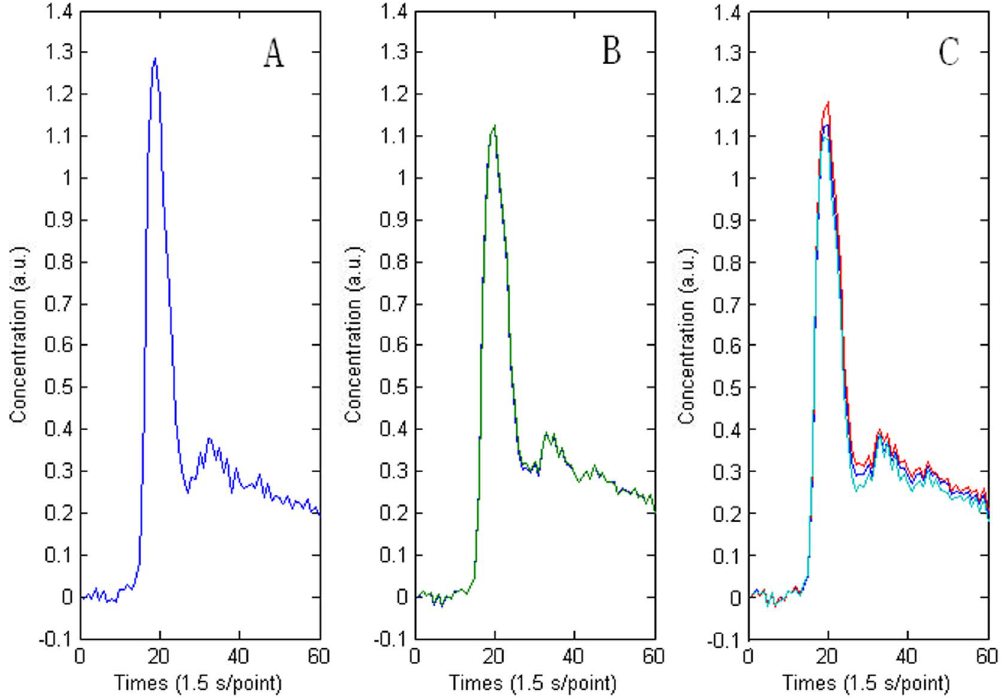
Figure 5. Comparison of reproducibility of the AIF detection using AH (A), FCM (B), and k -means (C) clustering methods. Each algorithm was executed independently 100 times in succession, and the robustness values were respectively 0.0000 for AH, 0.0032 for FCM, and 0.0007 for k -means.